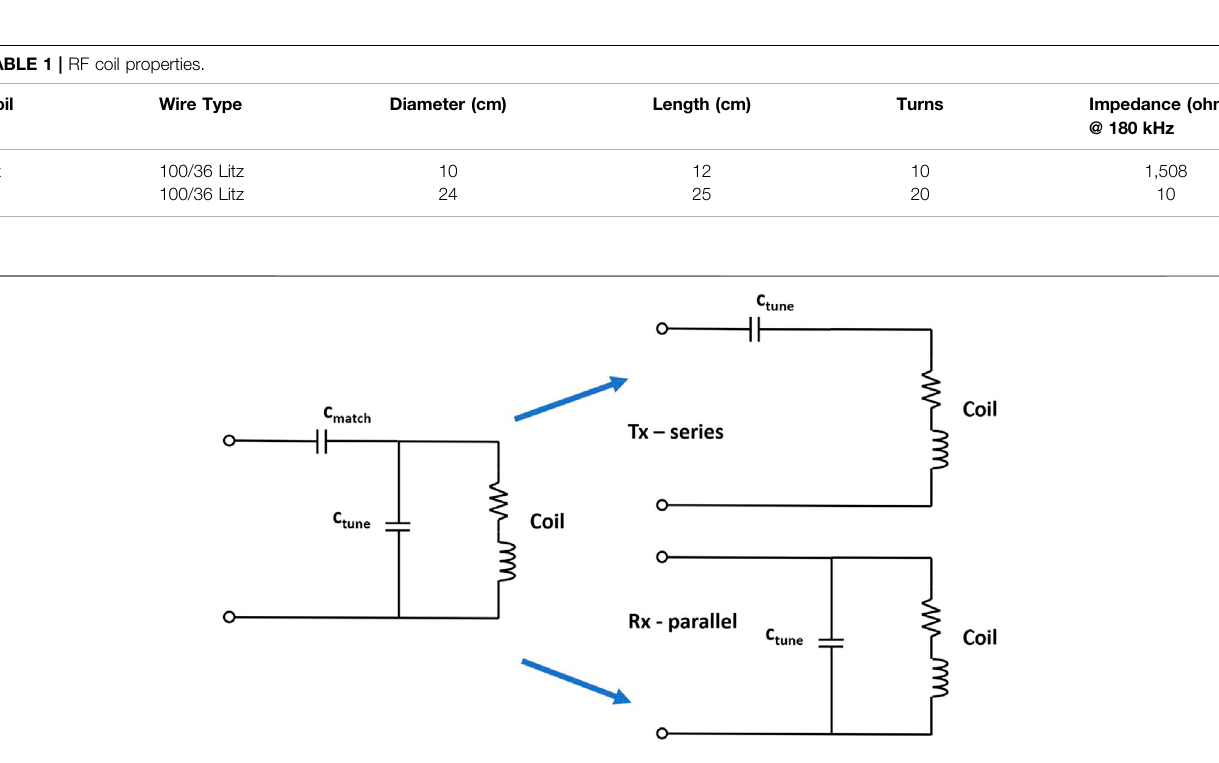
Frontiers in Physics |